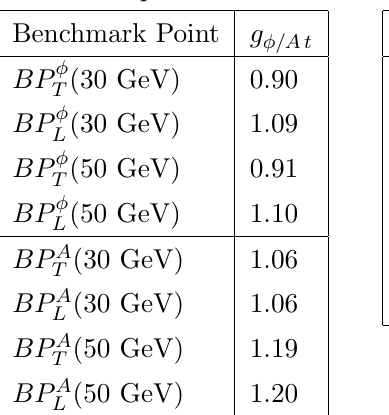
Table 1. Benchmark Points selected to study NP e(cid:11)ects in four-top phenomenology. Subscripts T and L stand for tight and loose, for which the four-top production cross-section is 1.5 and 2 times larger than the SM cross-section,